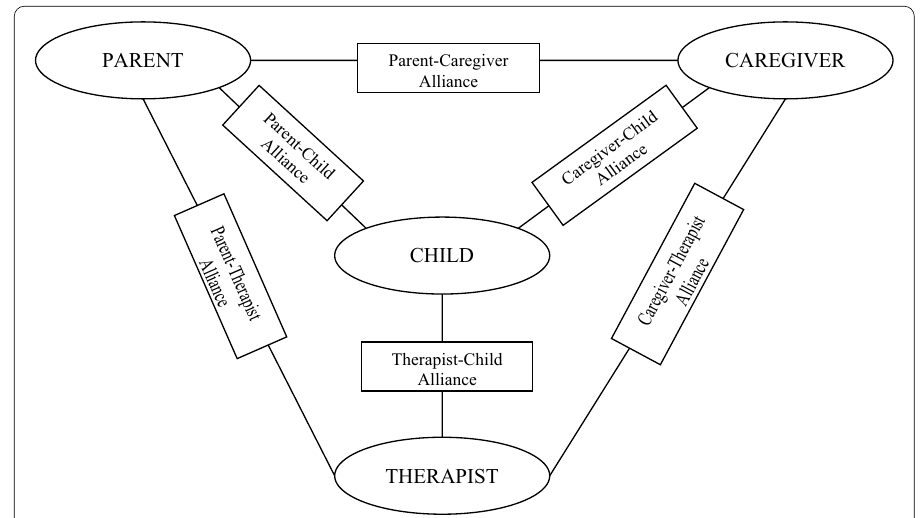
Fig. 1 Systemic therapeutic alliance in autism